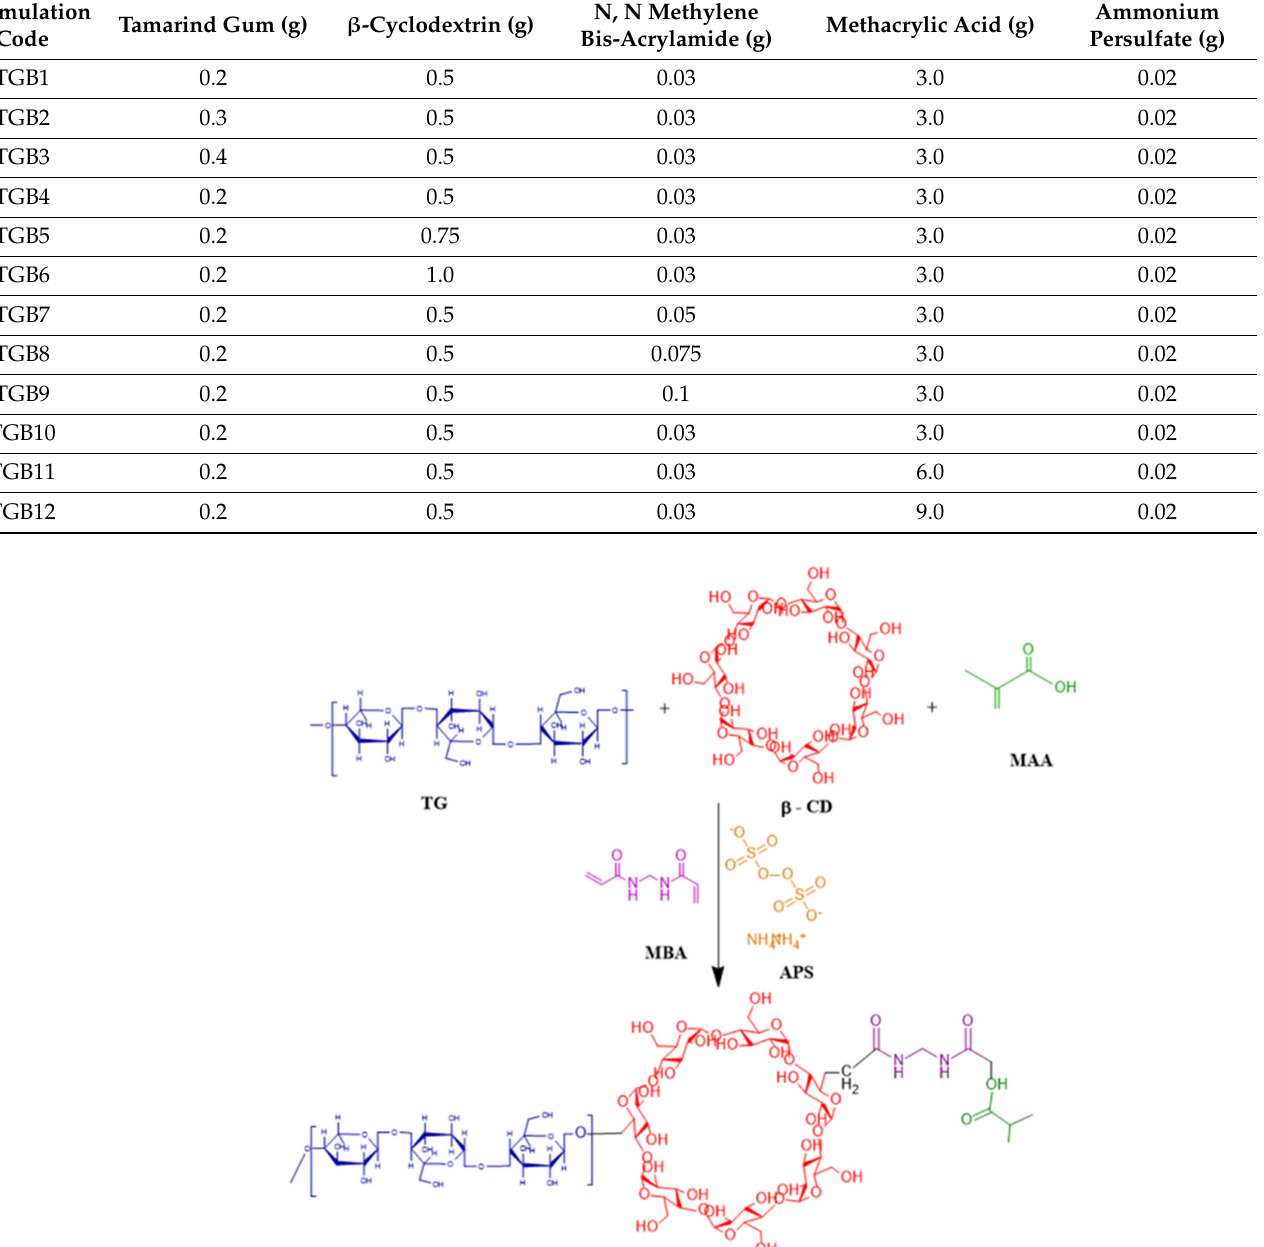
Table 6. Composition of tamarind/ β -CD-co-poly (methacrylate) hydrogel formulations.